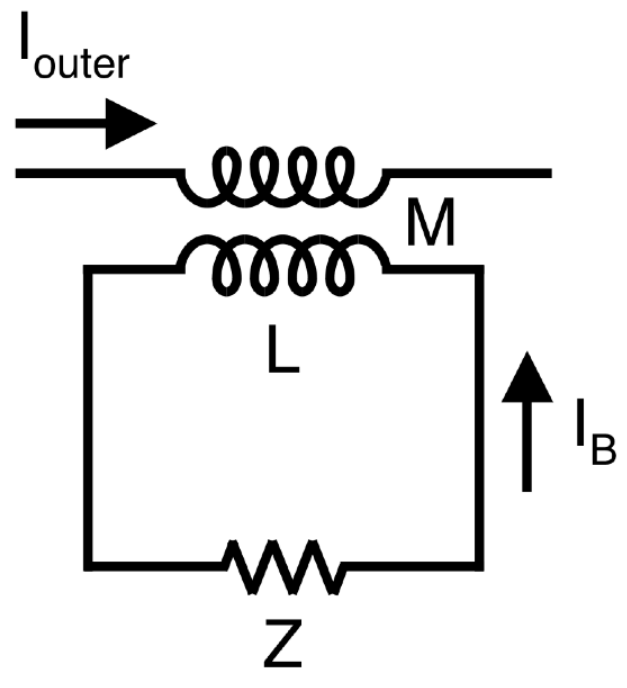
FIG. 3. Lumped-circuit model of a single outer-MITL B -dot current